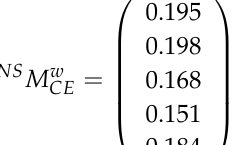
Figure 3. Relation between weighted NS-cross entropy values and acceptance level line of alternatives. 6. Comparative Study and Discussion In literature only two MADM strategies [144,145] have been proposed. No MADGM strategy is available. So the proposed MAGDM is novel and non-comparable with the existing cross entropy under SVNS for numerical example. i.